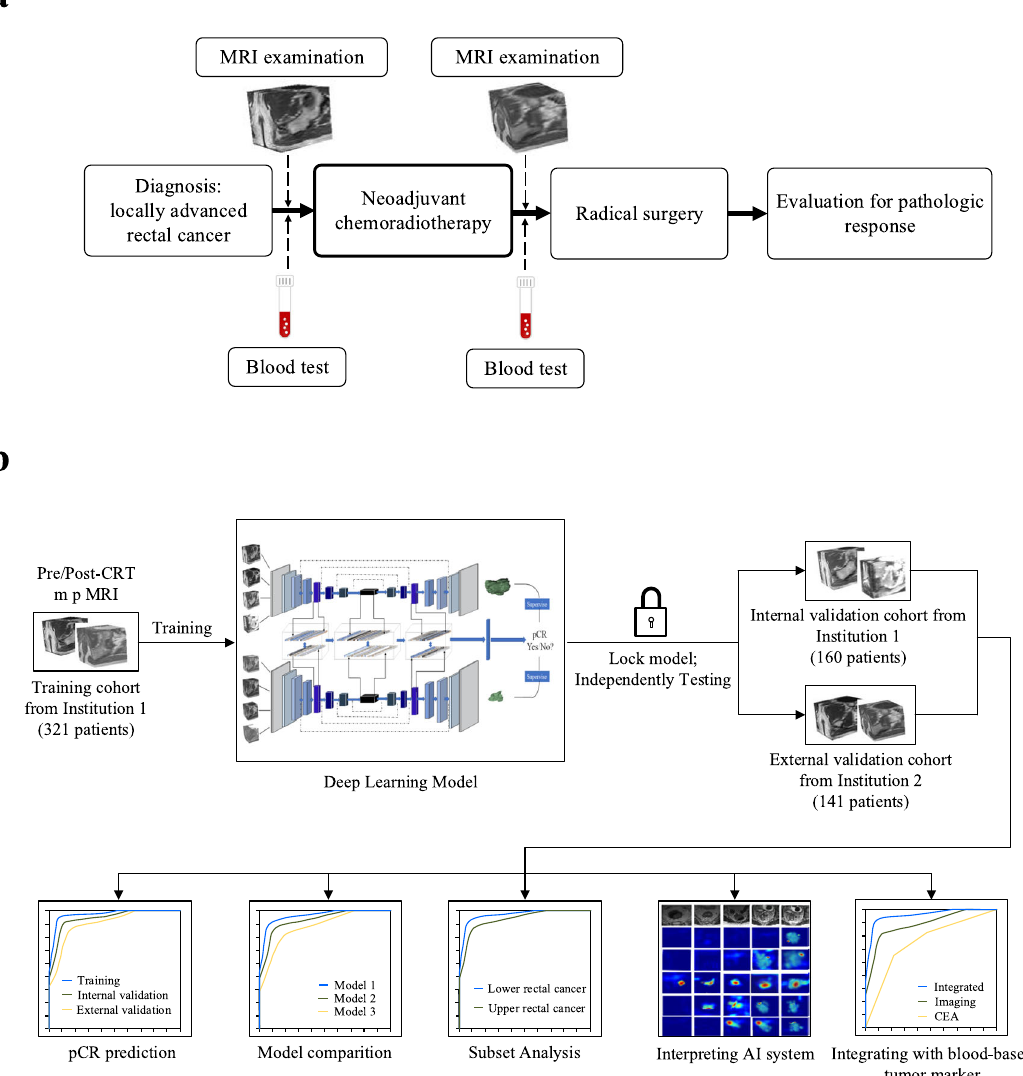
Fig. 1 Clinical work fl ow and study design. a Diagnosis, treatment, and response evaluation for patients with rectal cancer. MRI examinations and blood tests were performed for each patient before and after neoadjuvant chemoradiotherapy. b Development and validation of a deep learning system to predict pathologic complete response from longitudinal